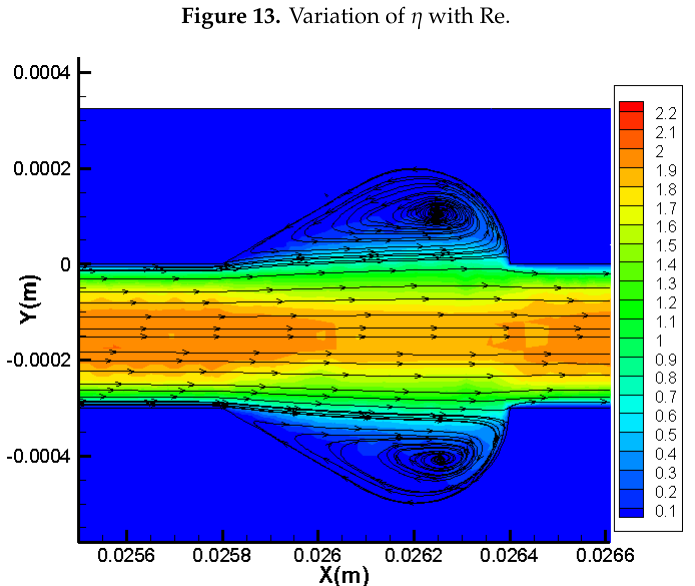
Figure 14. Local velocity distribution and streamlines in new proposed cavity.